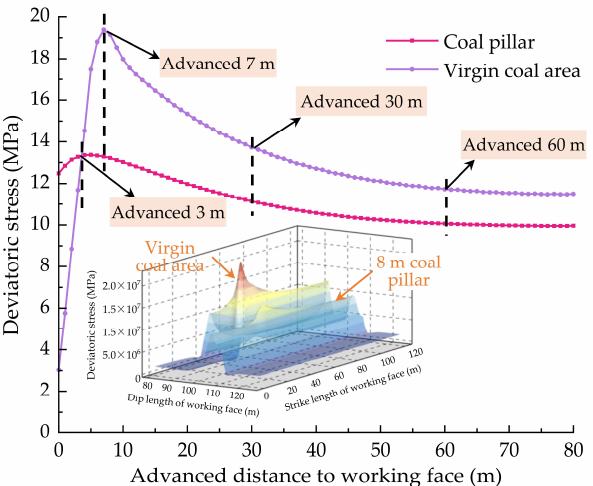
Figure 10. The distribution characteristics of surrounding rock advanced of the working face.